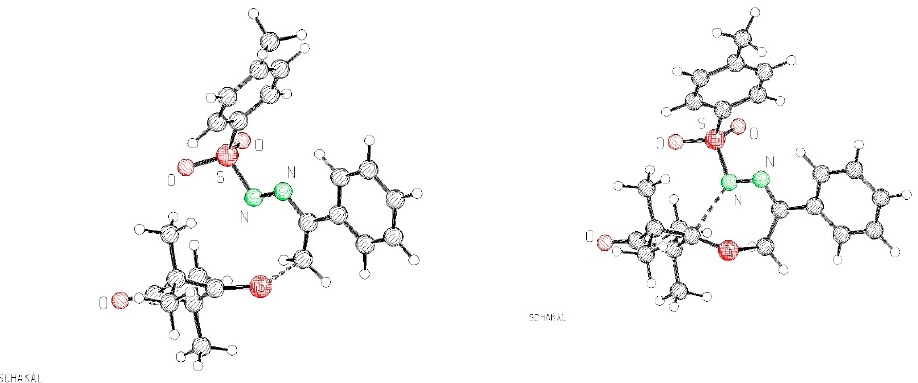
Figure 5. Transition states of the two-step cycloaddition of azoalkene 7a with 3-thioxocyclobutanone derivative 1i ; left side: TS A1 leading to zwitterion Z and TS A2 for the cyclization of Z leading to 1,3,4-thiadiazine derivative 9q .